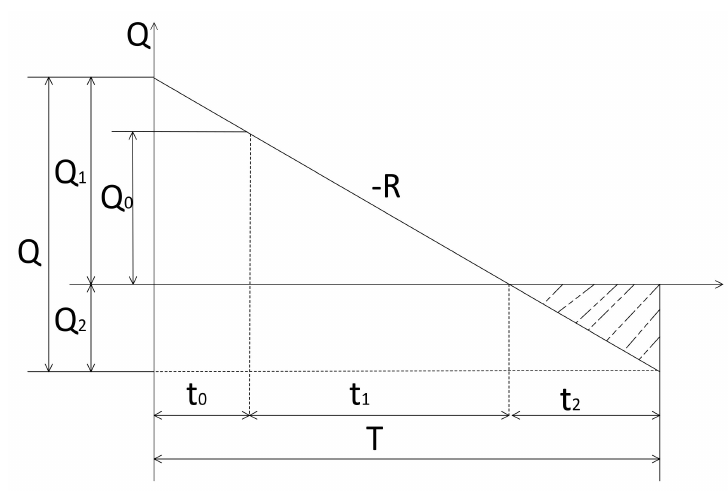
Figure 6. The storage volume changes over